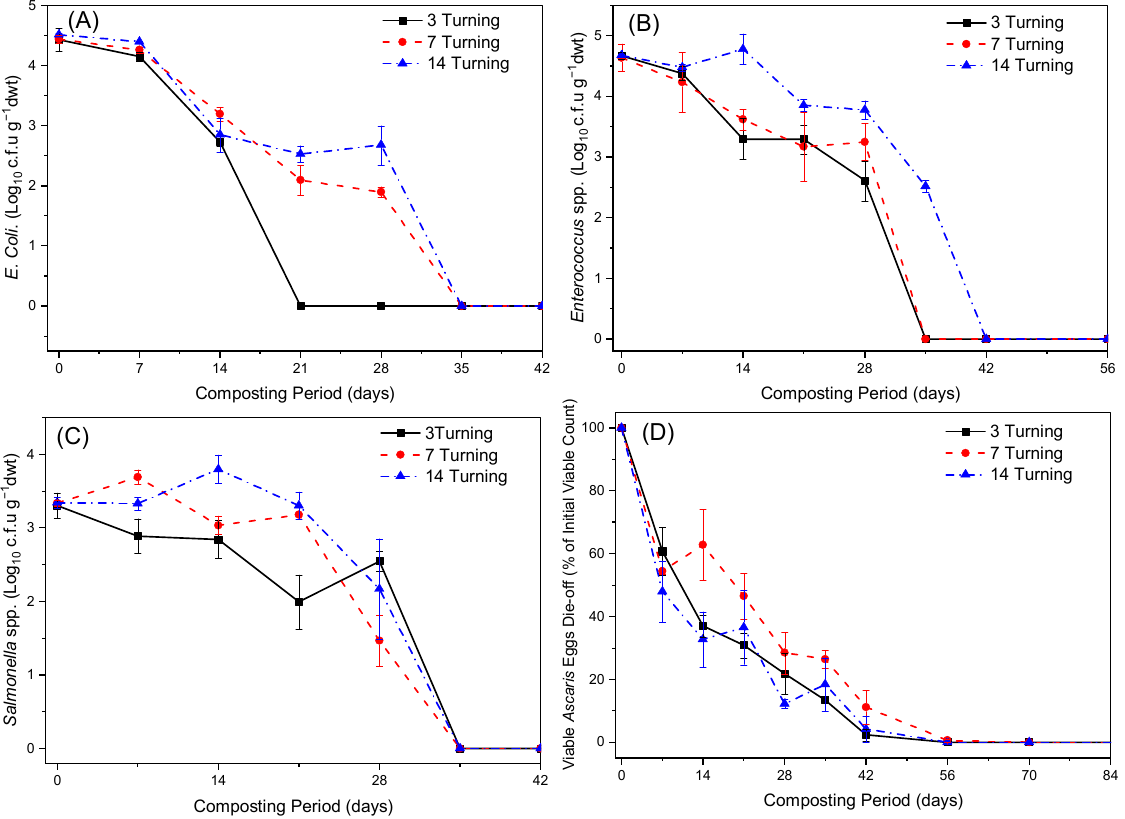
Figure 3. Changes in ( A ) E. coli population, ( B ) Enterococcus spp. population, ( C ) Salmonella spp. population and ( D ) Viable helminth eggs ( Ascaris eggs) during the composting of FS and sawdust using 3 days turning frequency—3 Turning, 7 days turning frequency—7 Turning, and 14 days turning frequency—14 Turning. Error bars represent the standard error of n = 2.